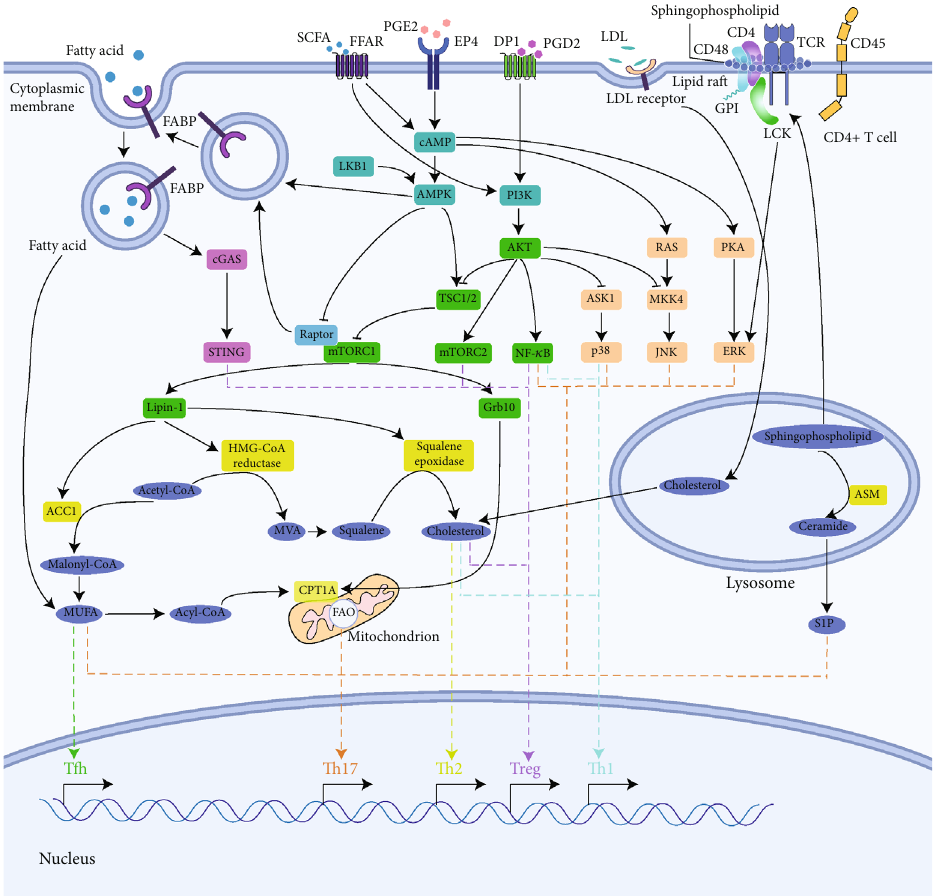
Figure 1: The role of lipid metabolism in CD4 + T cell di ff erentiation.Multiple signals a ff ect lipid biosynthesis and degradation. Moreover, lipids, such as fatty acid and cholesterol, also activate multiple signals to regulate T cell di ff erentiation. → : stimulation; ⊣ :